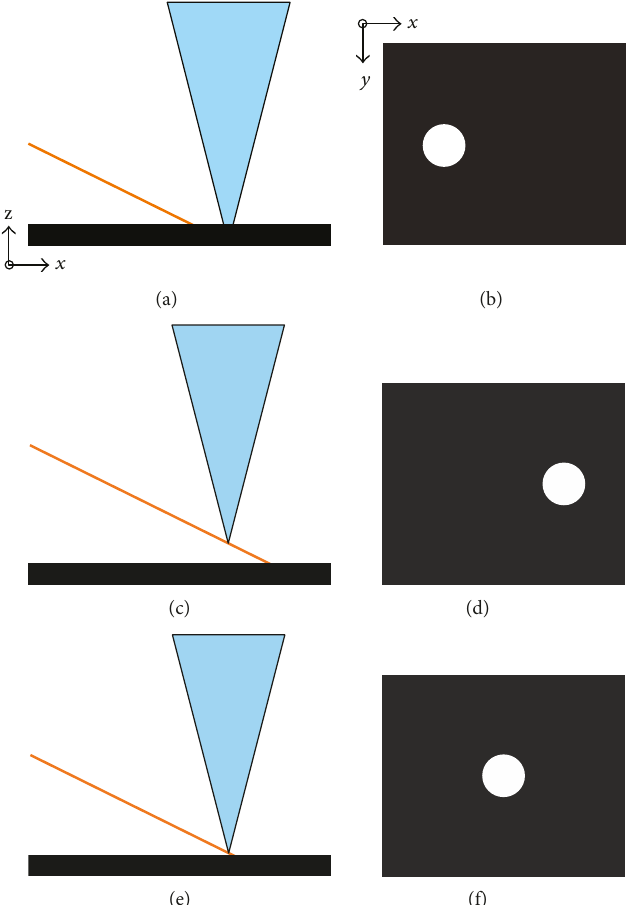
Figure 1: Triangulation method using a 635nm CW laser (beam entering from the left). The vertical beam converging on the sample represents the LIBS beam. (a), (c), and (e) show where the autofocus laser strikes the sample surface. (b), (d), and (f) show the camera images of the fi ltered autofocus laser